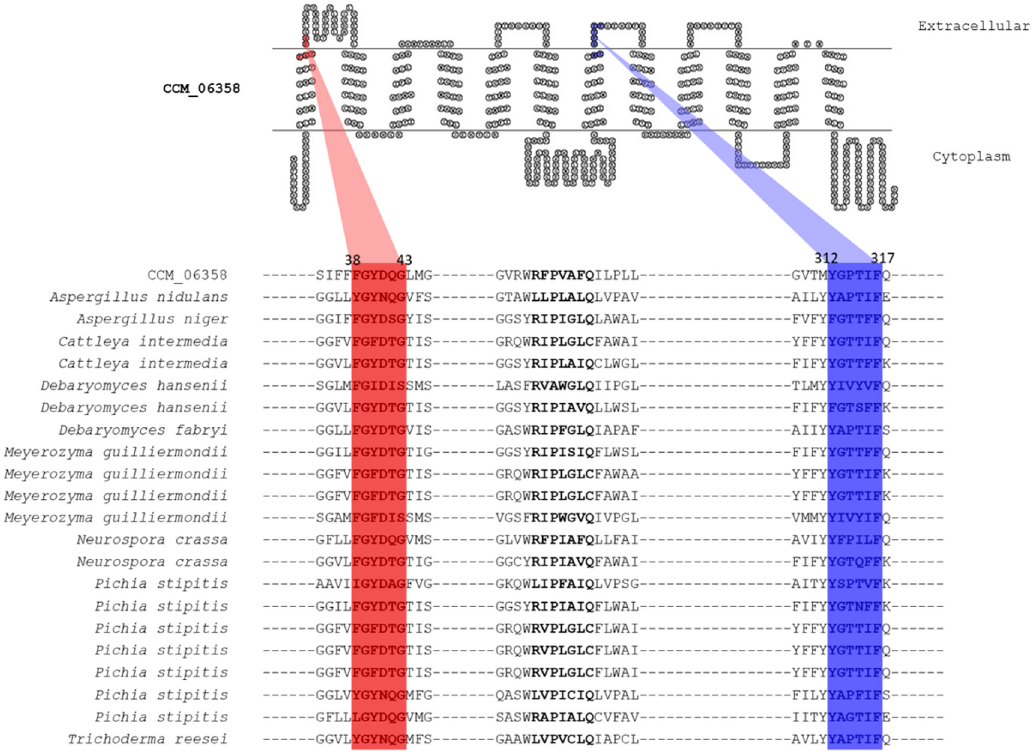
Figure 4. Multiple sequence alignment between CCM_06358 and the selected known / putative sugar transporters shows the highly conserved structural motifs for sugar transport function. Note: The most signatures in two conserved motifs were identified by MEME [27]. These were Phe38-Gly39- Tyr40-Asp41-Gln42-Gly43 (FGYDQG) and Tyr312-Gly313-Pro314-Thr315-Ile316-Phe317 (YGPTIF) in